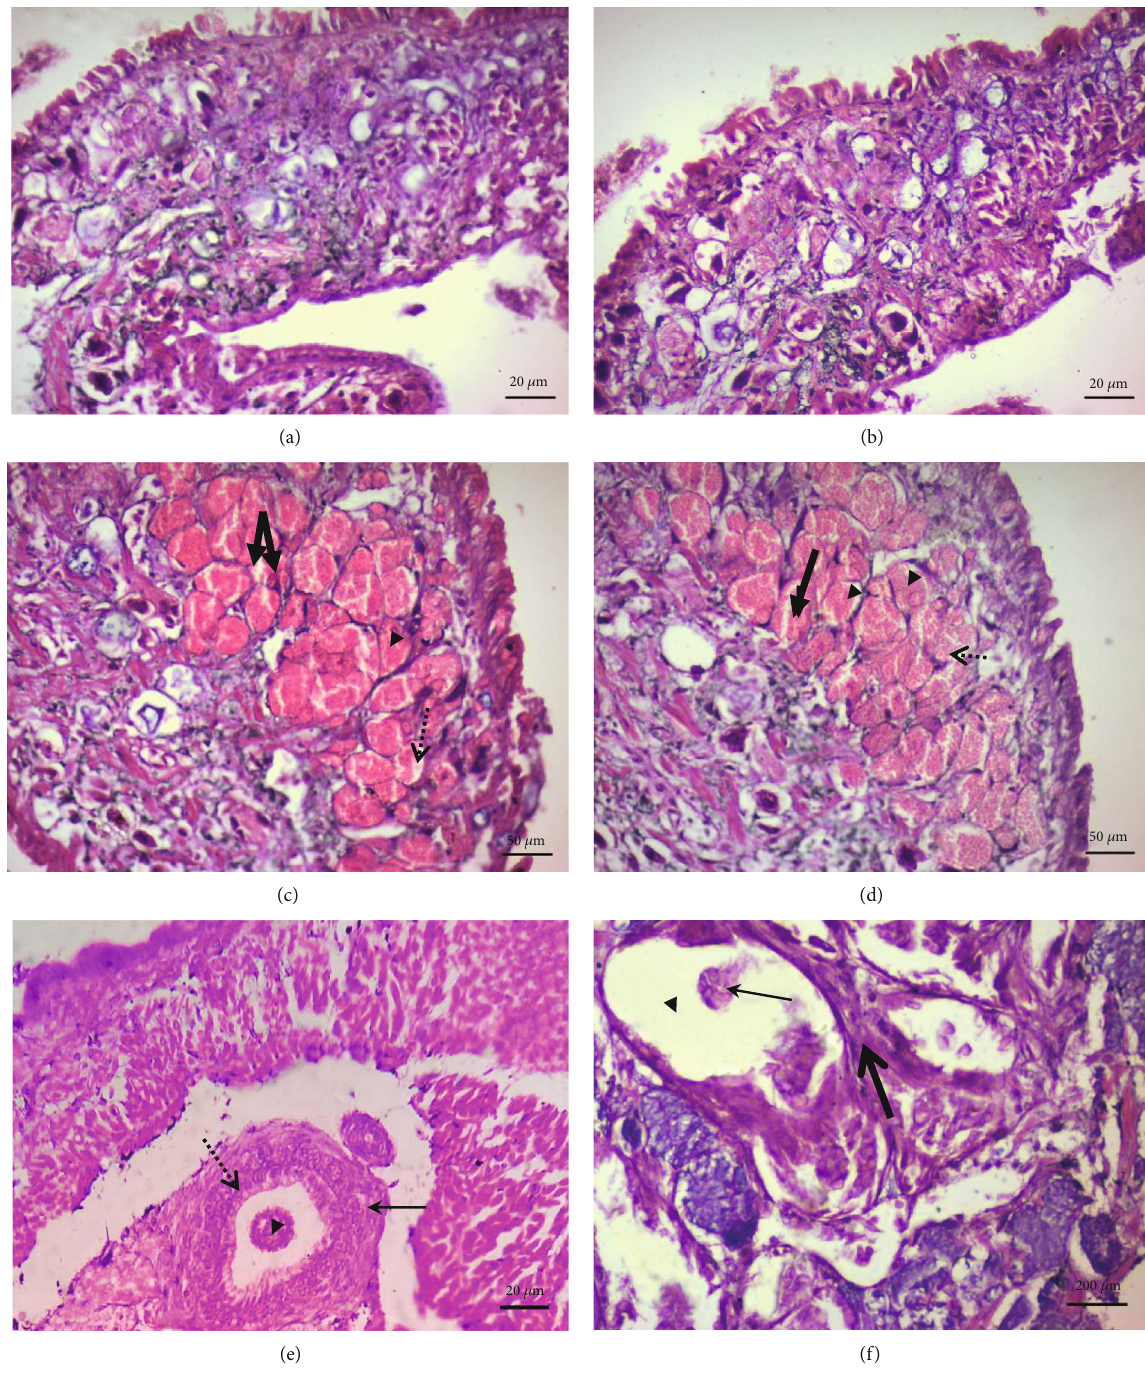
Figure 3: Histological transverse sections of B. alexandrina snails showing cephalopodal tissue. (a, b) are of naïve snails maintained on algae (a) and lettuce (b). (c, d) are of infected snails maintained on algae and lettuce, respectively, showing live S. mansoni mother sporocysts with normal development pattern; some of them contain single sporocyst cluster (thin arrow), and others contain multiple sporocyst clusters (thick arrow). (e, f) are of snails that resisted infection. Cephalopodal tissue is seen showing dead sporocyst (thin arrow) surrounded by granuloma- like structure consisting of layers of fl attened hemocytes followed by concentric layer of fi broblasts (thick arrow) (e). The mantle collar region shows the sporocysts losing their identical cluster-like shape and presence of germinal cells lacking nucleoli. The size of the vacant space (thin arrow) is wider than in normal sporocysts. Note, presence of fi broblast lamination (thick arrow) surrounding the sporocysts ’ tegument